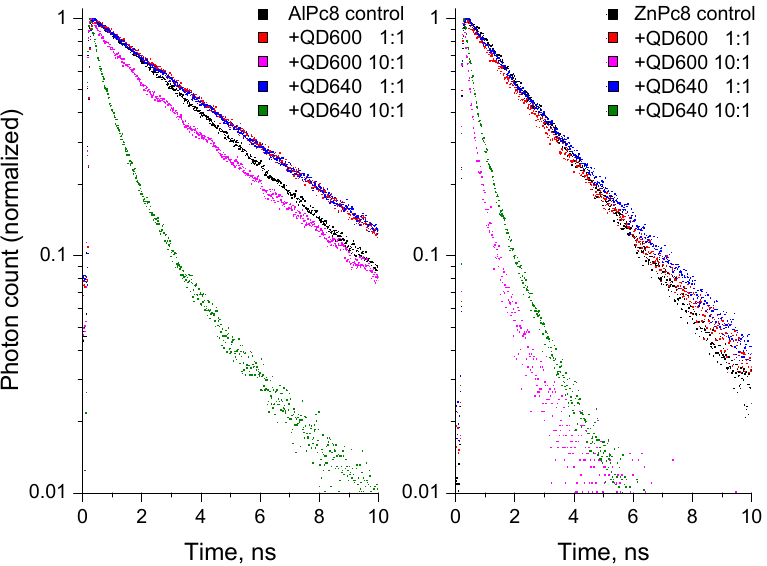
Figure A4. Normalized absorption spectra of carboxyphthalocyanines AlPc8 ( A ), ZnPc8 ( B ), and ZnPc16 ( C ) in the long-wavelength region in an aqueous solution and in the presence of various concentrations of QD600. The insets show the position of the Q I absorption band of the Pc depending on the QD concentration of in the solution.